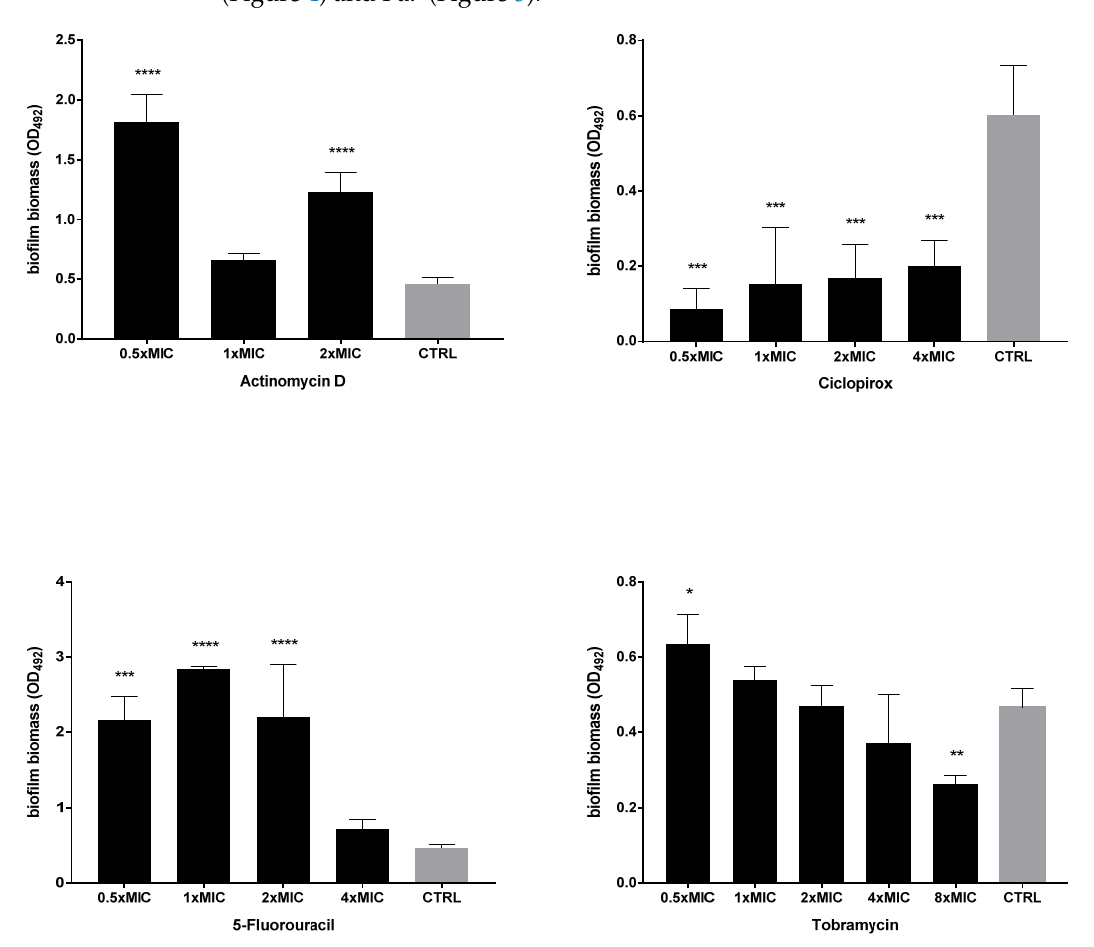
Figure 4. Dispersal activity against preformed biofilms by P. aeruginosa PaPh32. The efficacy of actinomycin D, ciclopirox, and 5-fluorouracil to disperse 24 h mature biofilms by P. aeruginosa PaPh32 was assessed, comparatively to tobramycin, using crystal violet assay. P. aeruginosa PaPh32 was chosen as representative of tobramycin-resistant strains. Each drug was tested at 0.5x and multiples of MIC value. Results were expressed as mean + SD of the residual biofilm biomass (OD 492 ) after 24 h of exposure. Control samples (CTRL) were not exposed to the drug. Statistical significance at ordinary one-way ANOVA + Holm–Sidak’s multiple comparisons post-test: * p < 0.05, ** p < 0.01, *** p < 0.001, **** p < 0.0001 vs. CTRL.